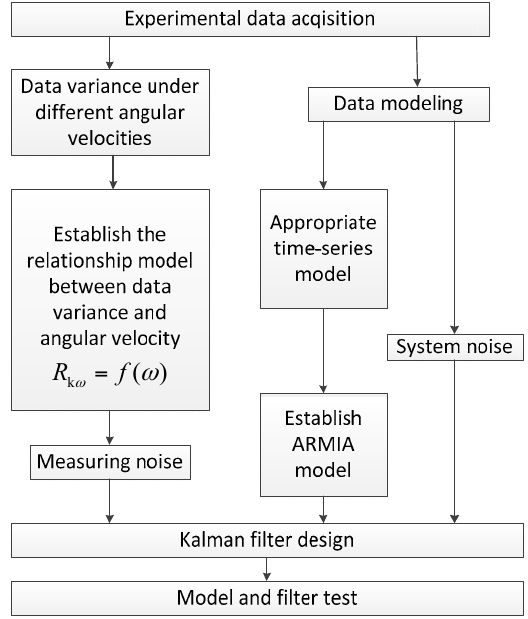
Figure 3. Experimental scheme.